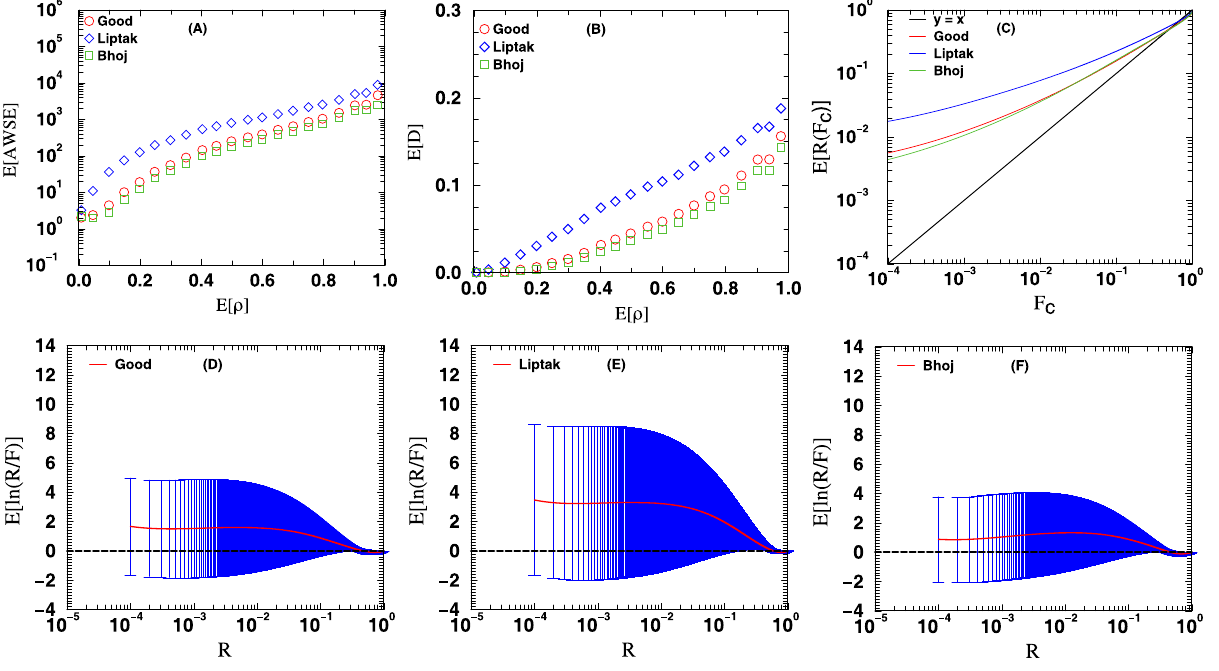
Figure 4. Methods that combine weighted independent P -values: Good, Lipta´k and Bhoj. The curves plotted above are the curves for the four different measures used to evaluate the accuracy of the computed P -value from combining the P -values of 12 P -value vectors. See text for more details.